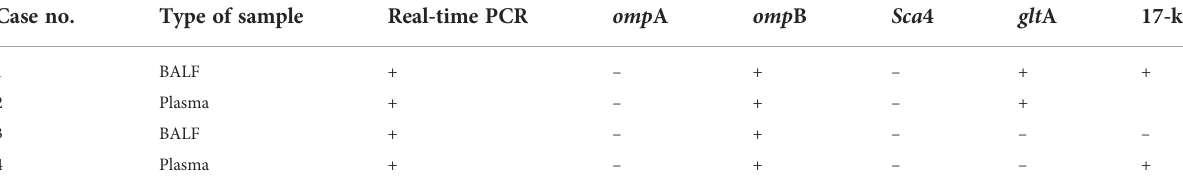
TABLE 2 Results of real-time PCR and semi/nested PCR. Case no.